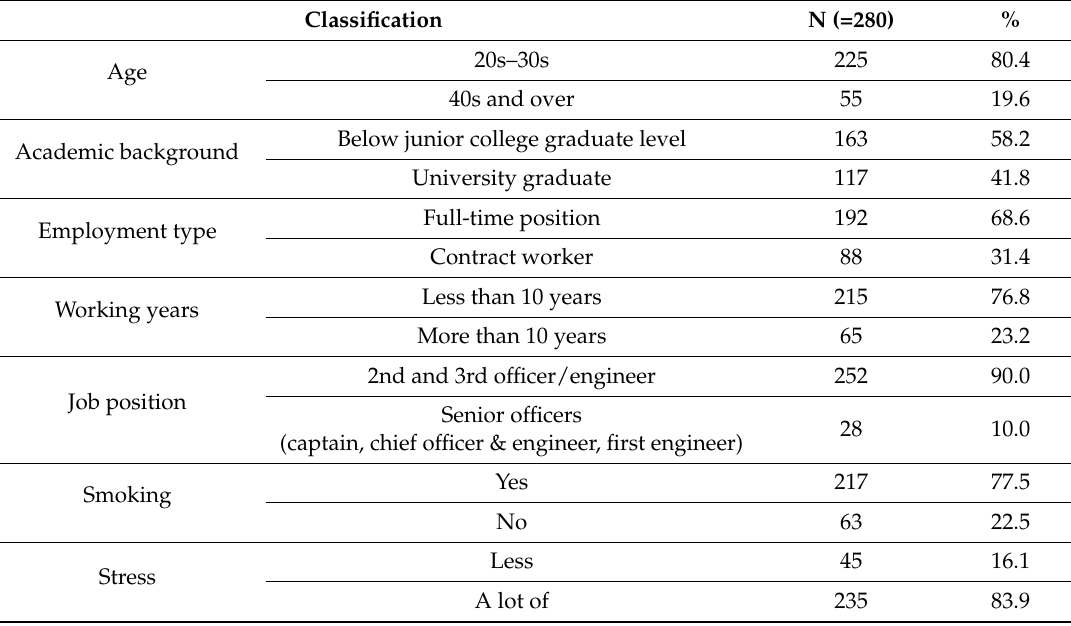
Table 1. General